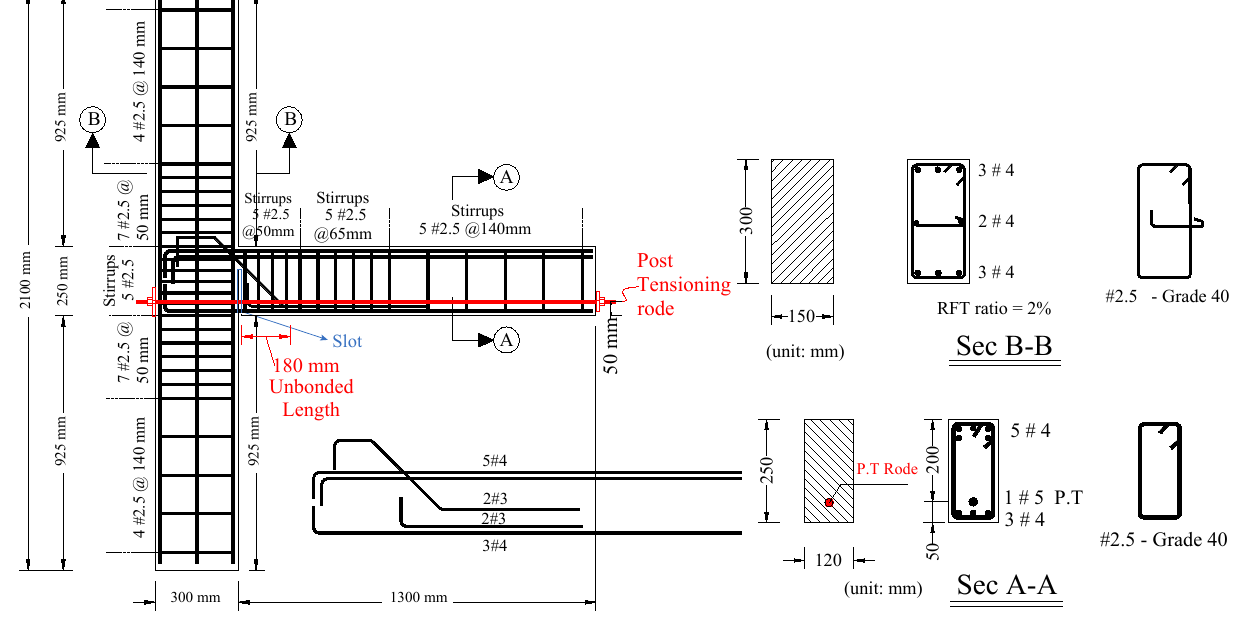
Figure 1. Details of slotted beam–column connection with